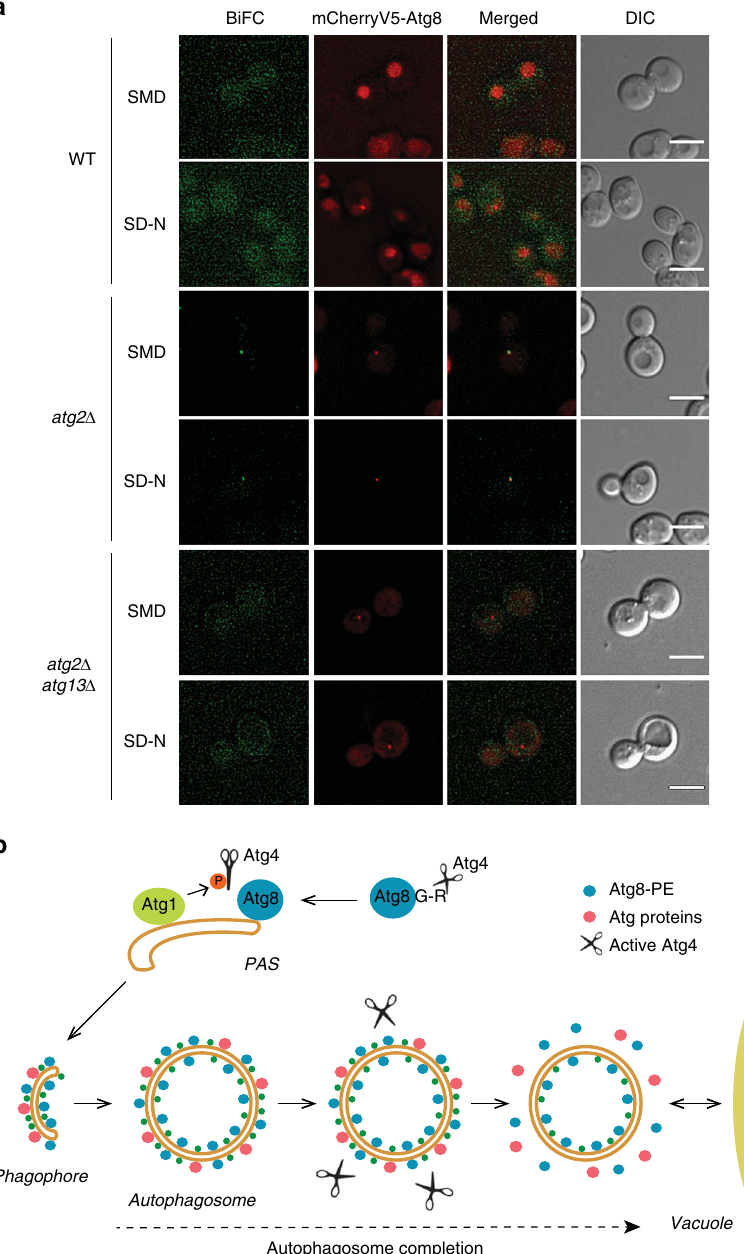
Fig. 4 Atg1 and Atg4 interact at the PAS. a Atg1 – Atg4 interaction at the PAS was visualized by BiFC. WT (JSY185), atg2 Δ (JSY190), and atg2 Δ atg13 Δ (JSY215) cells expressing both endogenous Atg1 – VN and Atg4 – VC, and carrying a pCumCherryV5ATG8 plasmid were grown in SMD before being nitrogen starved in SD-N medium for 1 h. Fluorescence images were taken before and after nitrogen starvation. Differential interference contrast (DIC). Scale bar , 5 µ m. b Mechanistic model for the regulation of Atg4 during autophagy. Newly synthesized Atg8 is constitutively processed by the cysteine protease Atg4 in the cytoplasm, where it is not inhibited by Atg1. After the cleavage of the C-terminal arginine, a glycine residue is exposed allowing Atg8 to be conjugated to the PE on autophagosomal membranes at the PAS. During the phagophore expansion, the Atg4 adjacent or coming in proximity of autophagosomal membranes, is locally inhibited by the action of the Atg1 kinase complex. Upon autophagosome completion, the release of Atg1 form autophagosomal membranes and/or its local inactivation allows Atg4 to act on Atg8 – PE and release Atg8 from the PE anchor. This molecular mechanism, possibly together with other unknown regulatory events, would drive the dissociation of other Atg proteins from the surface of autophagosomes allowing their subsequent fusion with